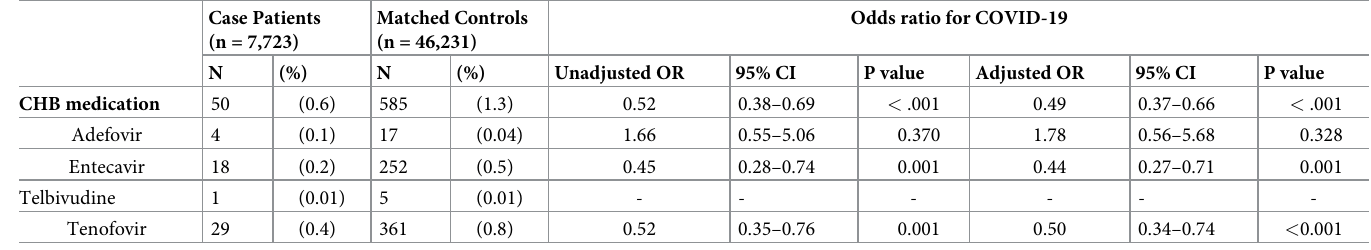
Table 3. Association between use of CHB medication and risk of